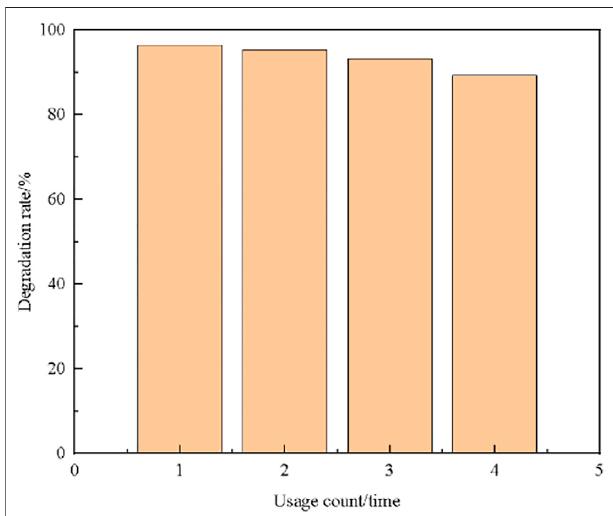
FIGURE 11 | The effect of times of